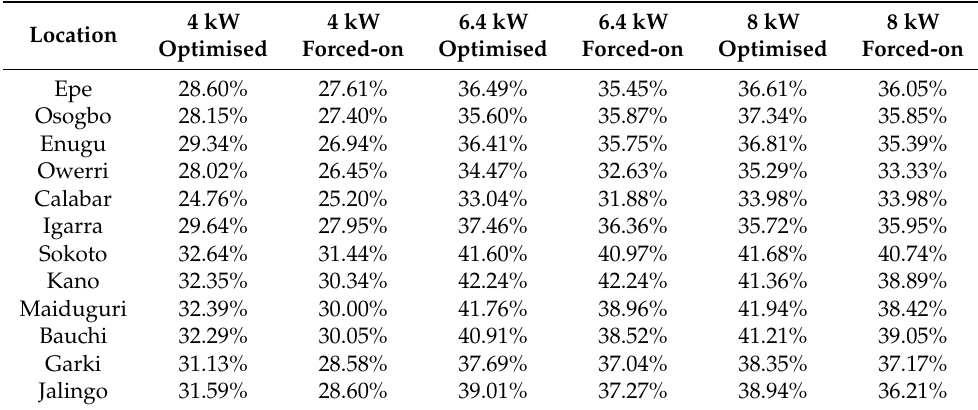
Table 11. Simulated percentage savings on fuel L/year.